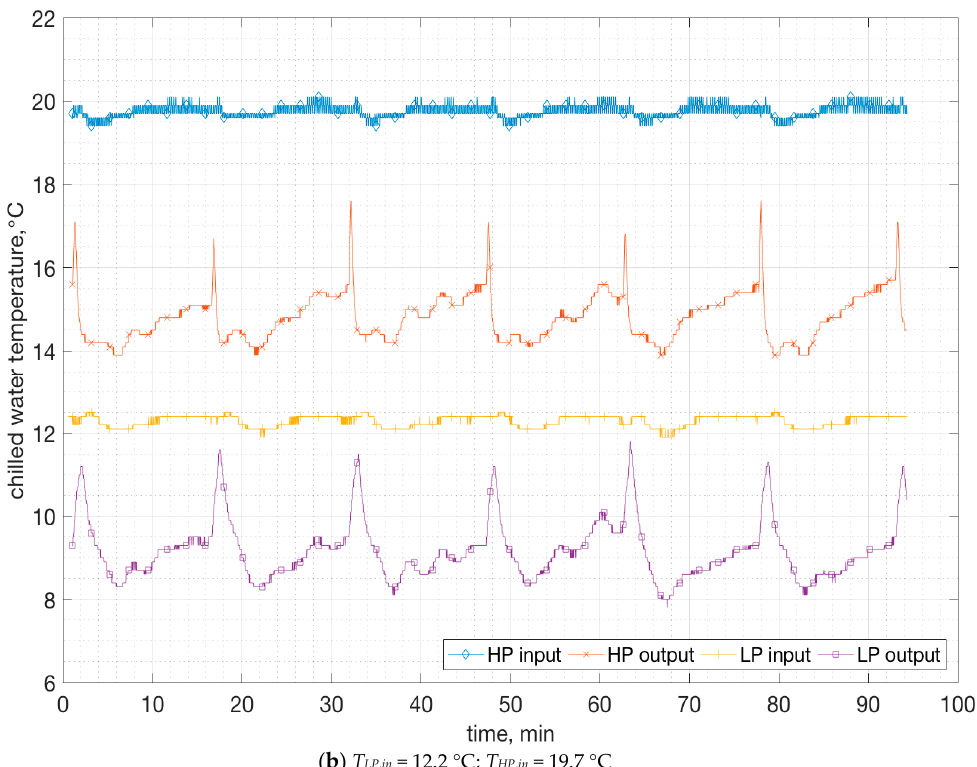
Figure 3. Examples of the inlet and outlet temperatures stability of the heating ( a ) and chilled ( b ) water registered during the measurement of the chiller performance under the new control system. Figure ( a ) and ( b ) were registered during the same time period.